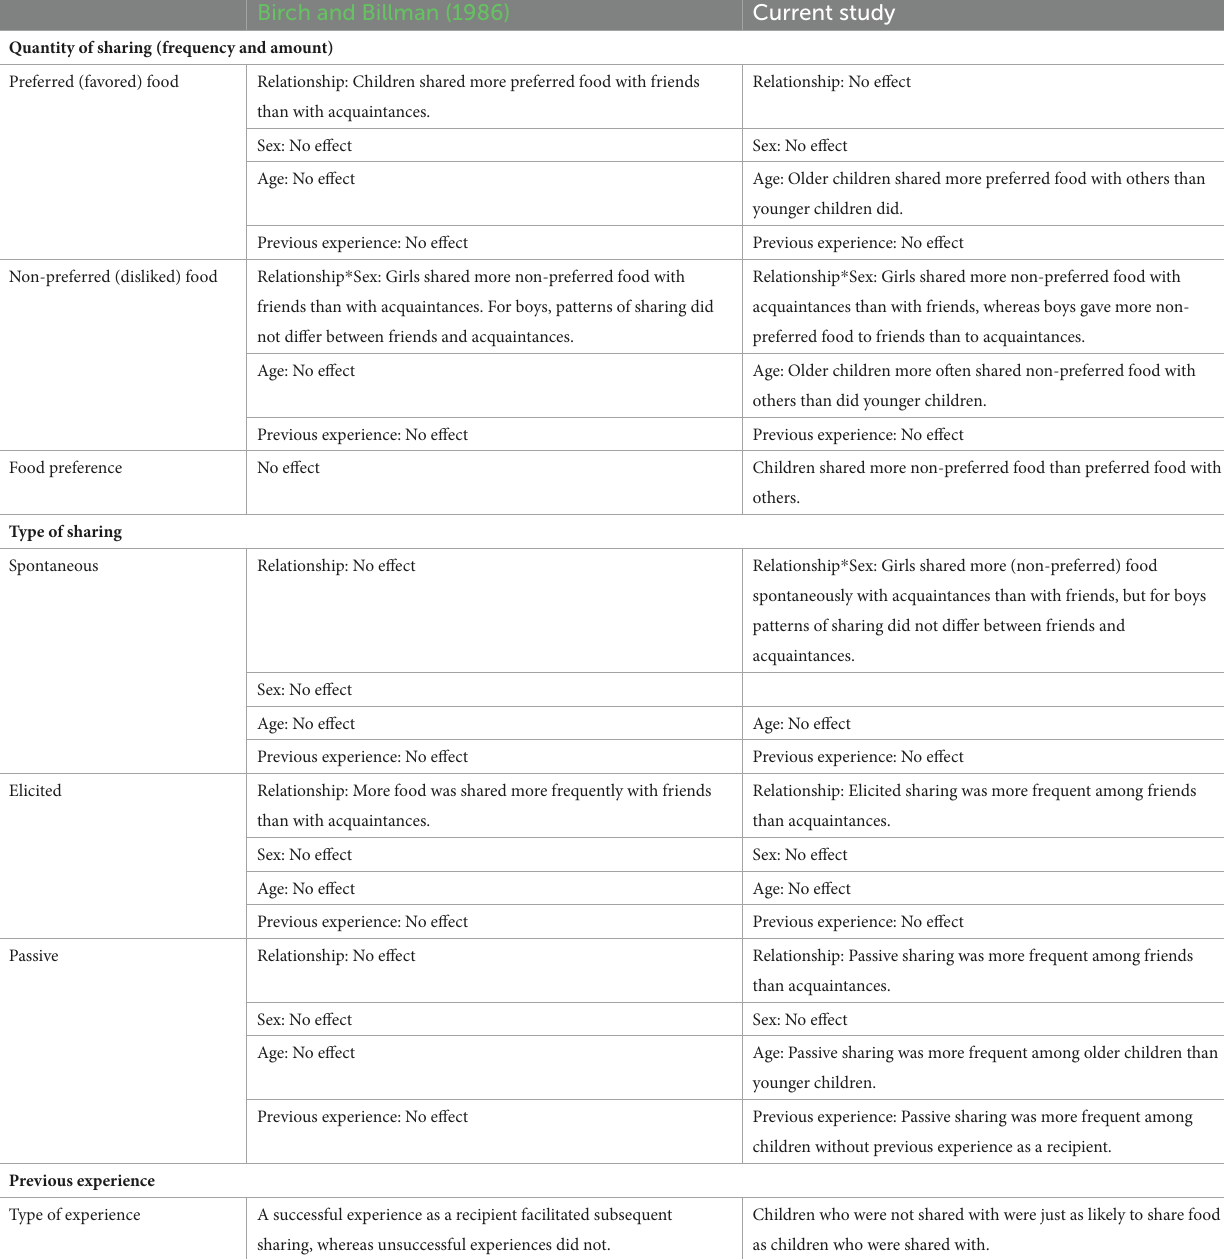
TABLE 1 Overview and comparison of results by Birch and Billman (1986) and the current study. Birch and Billman